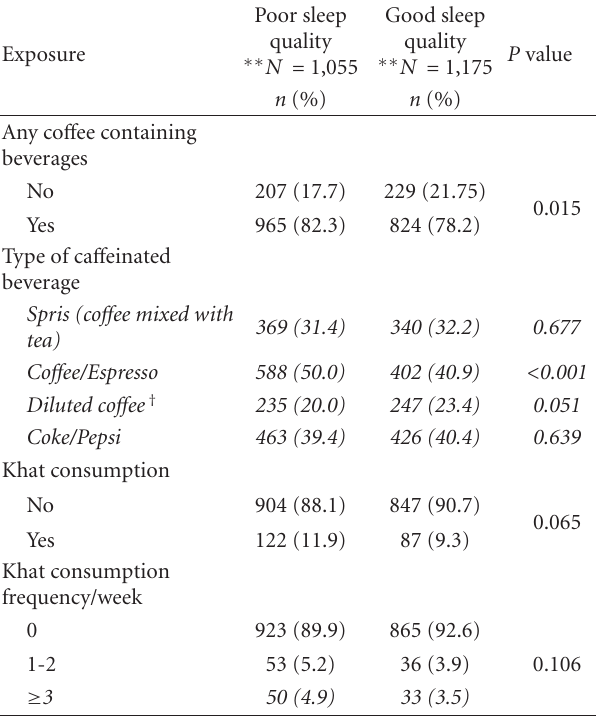
Table 4: Consumption of ca ff einated beverages and khat use according to sleep